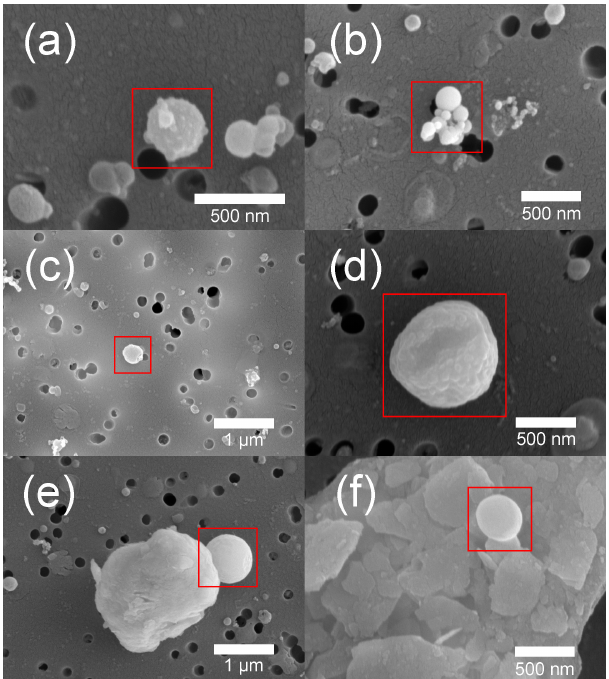
Figure 7. State of bioaerosols under SEM. All of the pictures depict non-dust samples collected in Erenhot; panel ( a ) shows ER4_11N, whereas the others are from